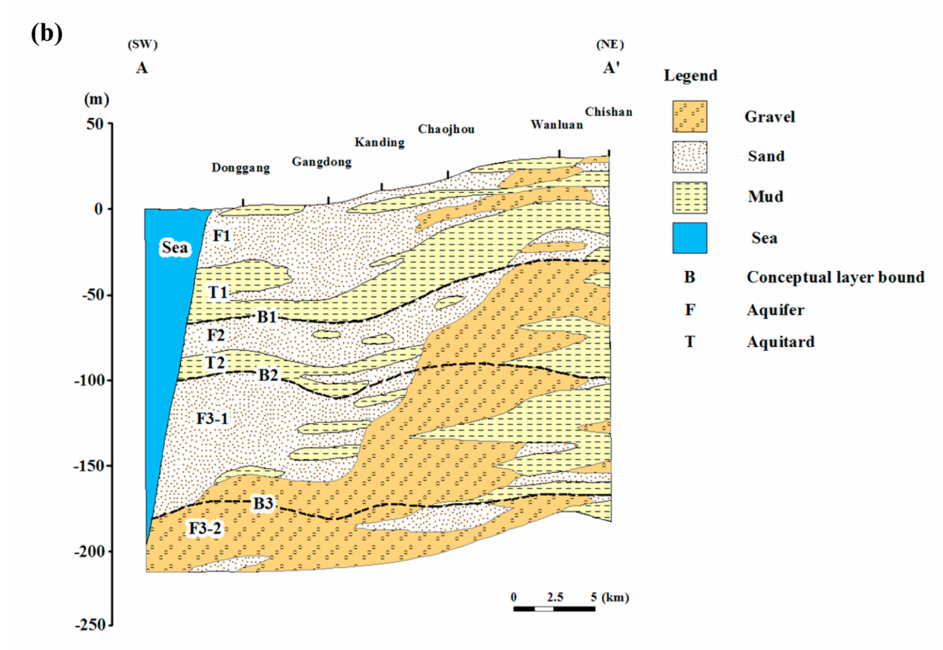
Figure 2. ( a ) The study area of Pingtung Plain in Taiwan; and ( b ) the cross-section (A–A (cid:48) ) representation of the hydrogeological